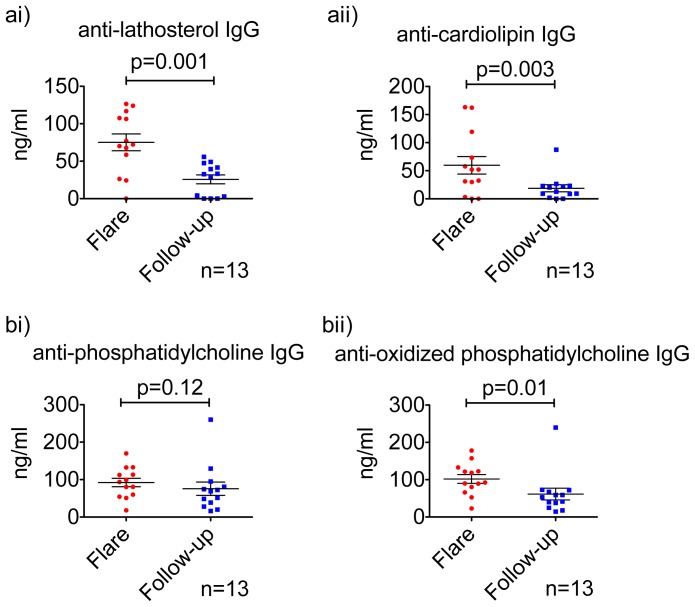
Anti-lipid responses against lathosterol, cardiolipin, phosphatidylcholine and oxidized-phosphatidylcholine.
Figure 4ai anti-lathosterol IgG levels in plasma. Figure 4aii anti-cardiolipin IgG levels in plasma. Figure 4bi anti-phosphatidylcholine IgG levels in plasma. Figure 4bi anti-oxidized phosphatidylcholine IgG levels in plasma. p<0.05 value considered significant in Wilcoxon test.